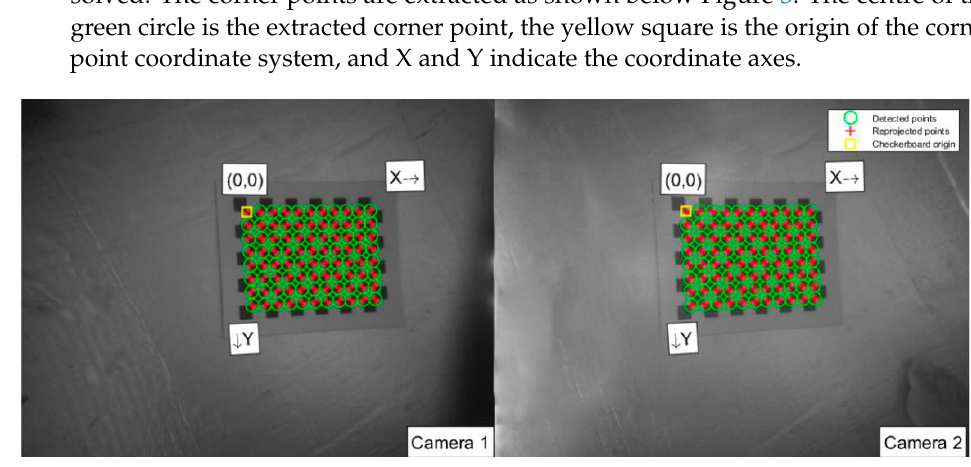
Figure 3. Corner Point Extraction of Calibration Board.